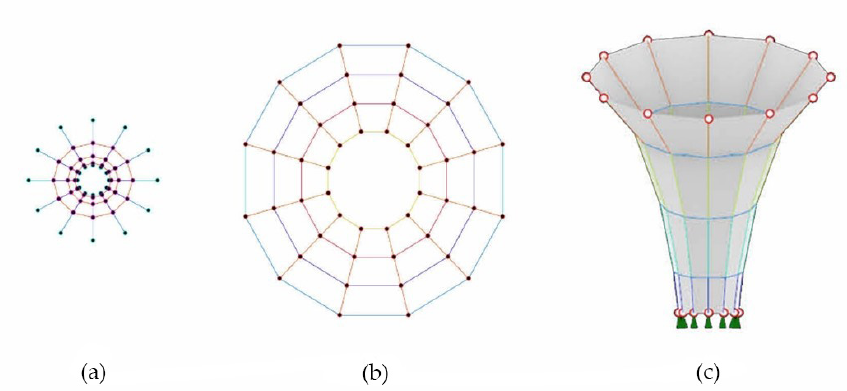
Figure 8. ( a , b ) Form and Force Diagram, ( c ) Thrust Diagram.